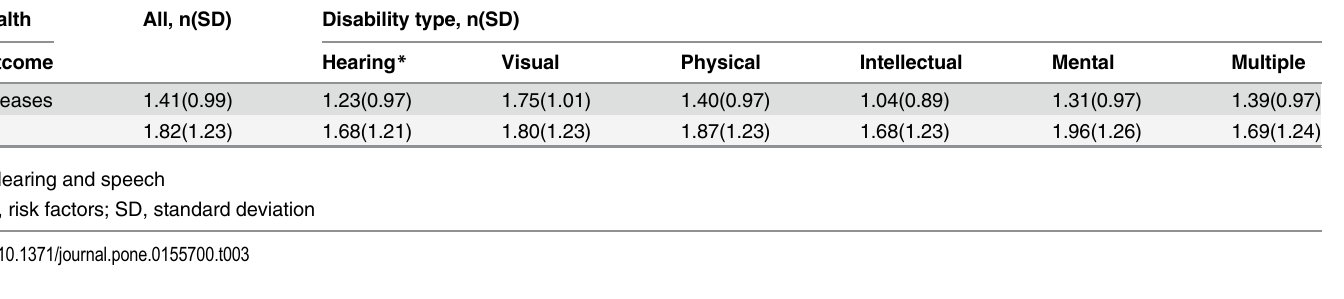
BMI (cid:1) 24, high blood glucose levels, and high blood lipid levels). Nevertheless, the mental limi- tation group fared better on two health variables — hepatic cysts and blood pressure. After adjusting for demographic characteristics, people with multiple disabilities were significantly more likely to have refractive error than those in the hearing and speech impairment group.